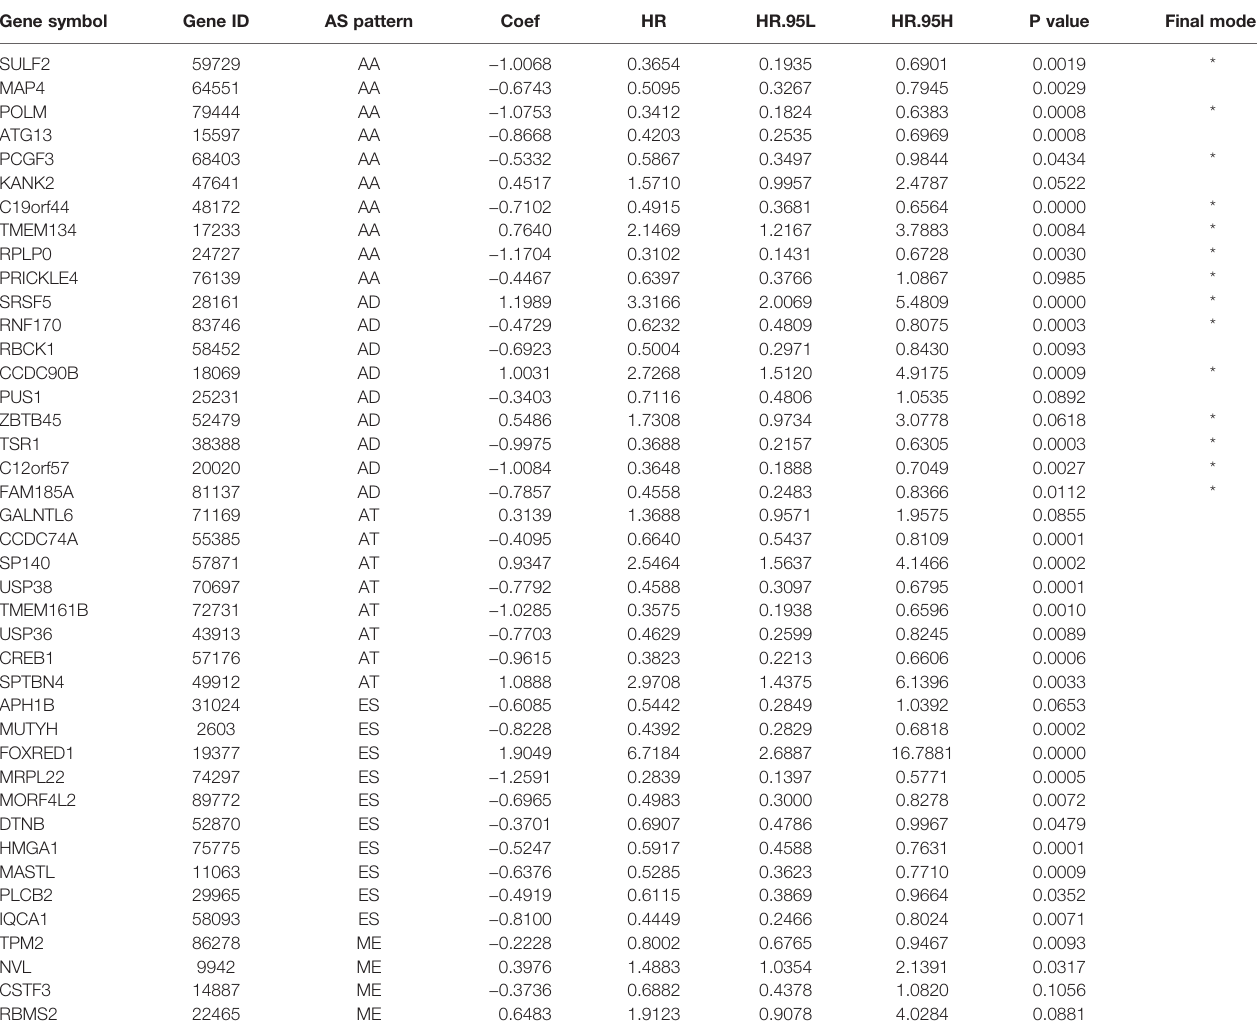
TABLE 2 | Multivariate Cox analysis of prognostic alternative splicing predicting overall survival. Gene